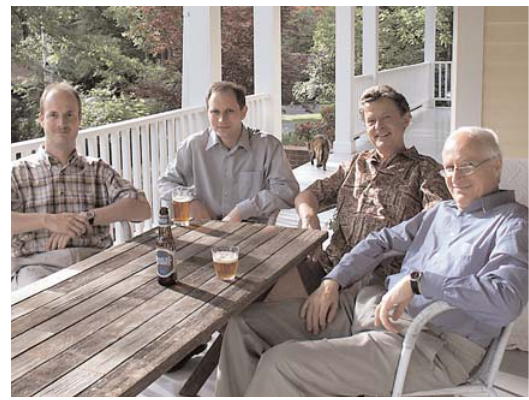
Figure 4: Relaxing after